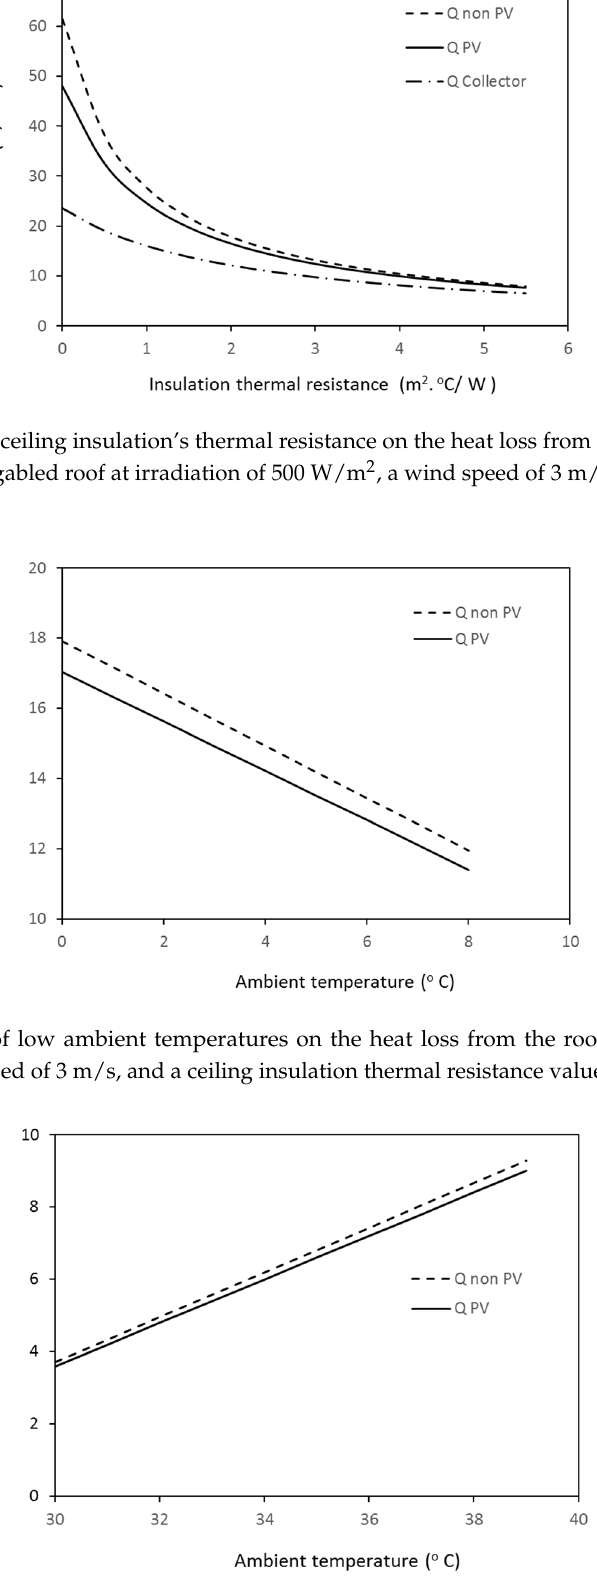
Figure 5. The effect of high ambient temperatures on the heat gain from the roof at irradiation of 500 W/m 2 , a wind speed of 3 m/s, and a ceiling insulation thermal resistance value of 4 m 2 · °C/W.